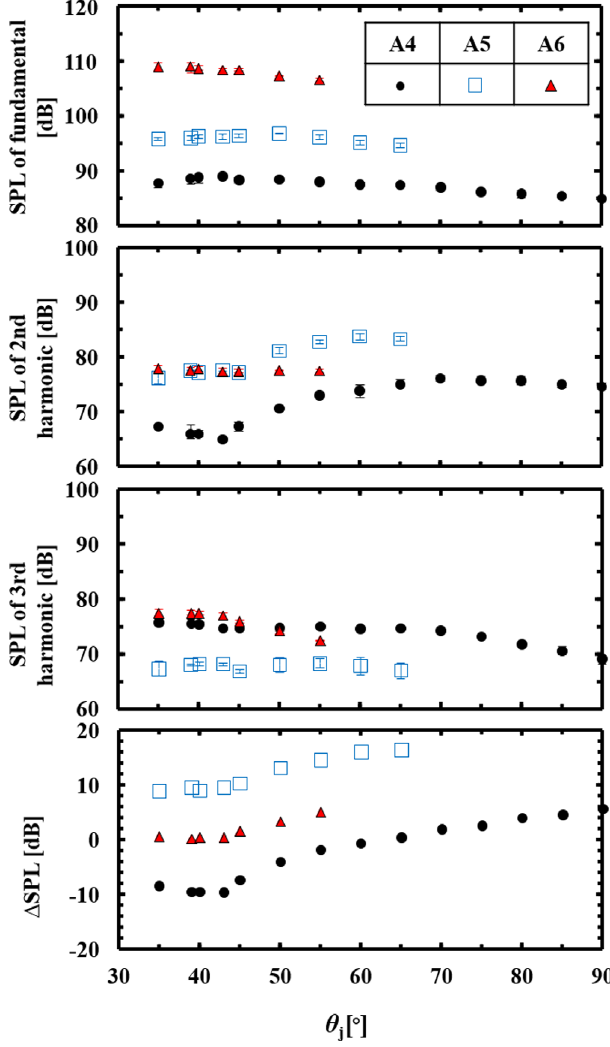
Figure A.2. Variations of harmonic structure with jet angle measured for fl ute with A4, A5, and A6 fi ngering. Lip-to-edge distance and jet offset were fi xed to the actual blowing conditions shown in Table 1 ( l / h = 5.6, y j,e / h = 0.24). Flow rate was fi xed to Q = 16 L/min ( U 0 = 21.5 m/s) for A5 and Q = 32 L/min ( U 0 = 43.0 m/s) for